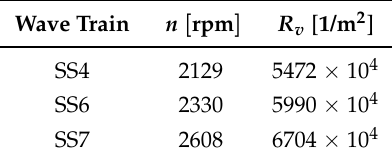
Table 6. Viscous coefficient in the equivalent porous